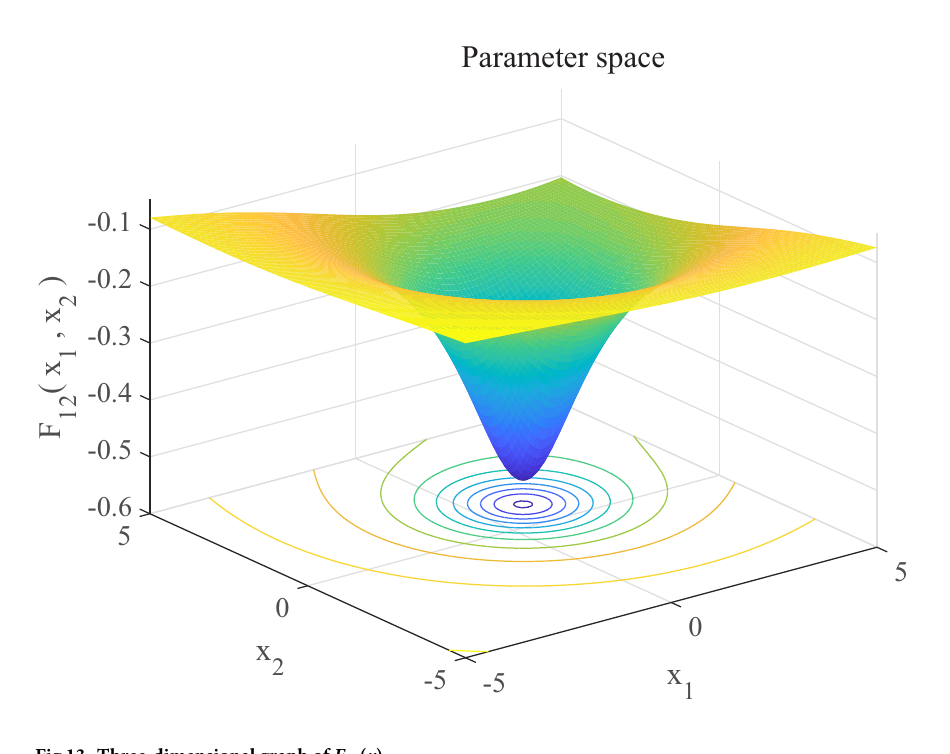
Fig 13. Three-dimensional graph of F 12 ( x